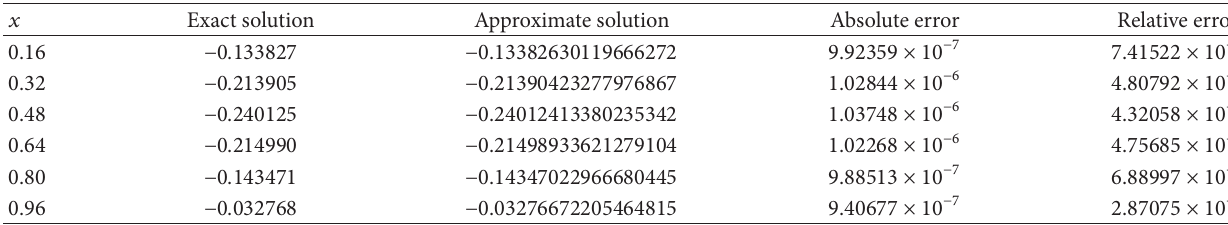
Table 1: Numerical results of 𝑢 1 (𝑥) for Example 1.